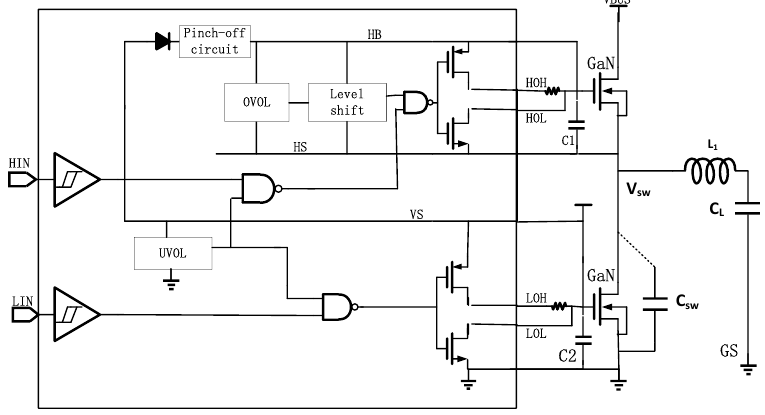
Figure 1. A gate driver of half bridge topology.